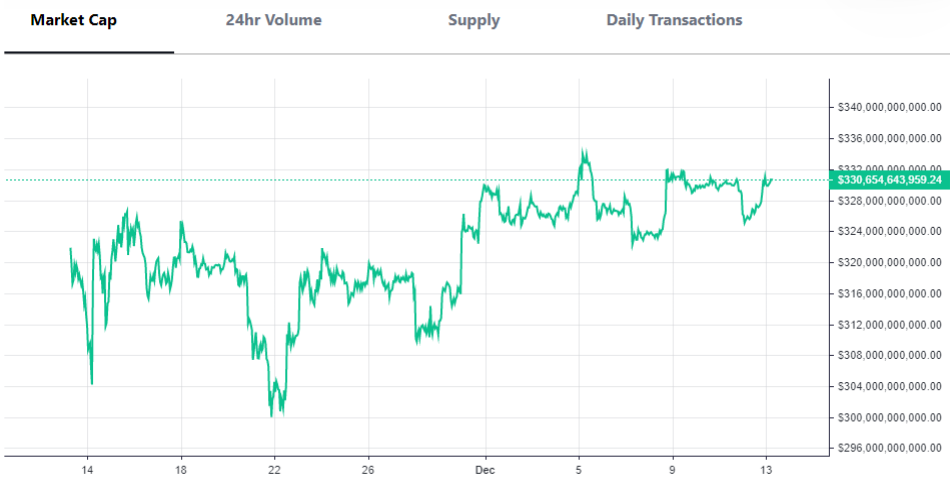
Figure 5. BCH Market capitalization in June 2021 was USD 13.1 B, and in December 2022, it reached USD 330.05 B [10].